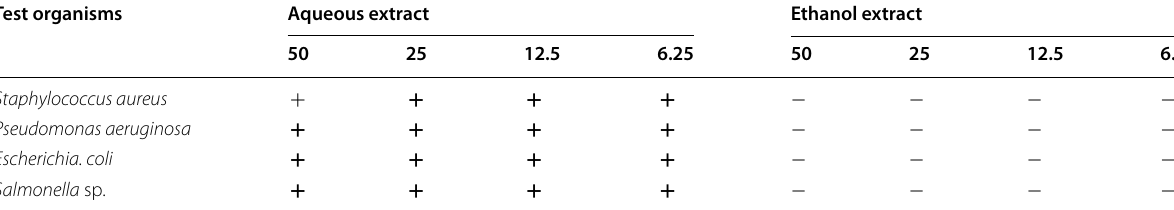
Table 7 Minimum bactericidal concentration (MBC) in mg/ml of aqueous and ethanol extract of Moringa oleifera leaf Test organisms